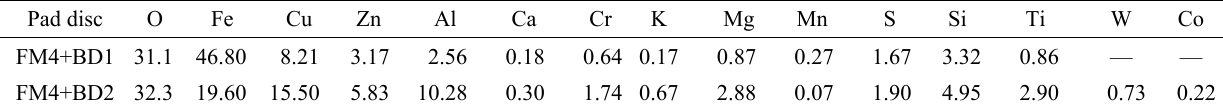
Table 3 XRF semi-quantitative analysis of the collected particles extracted from the aluminum substrate. Pad disc